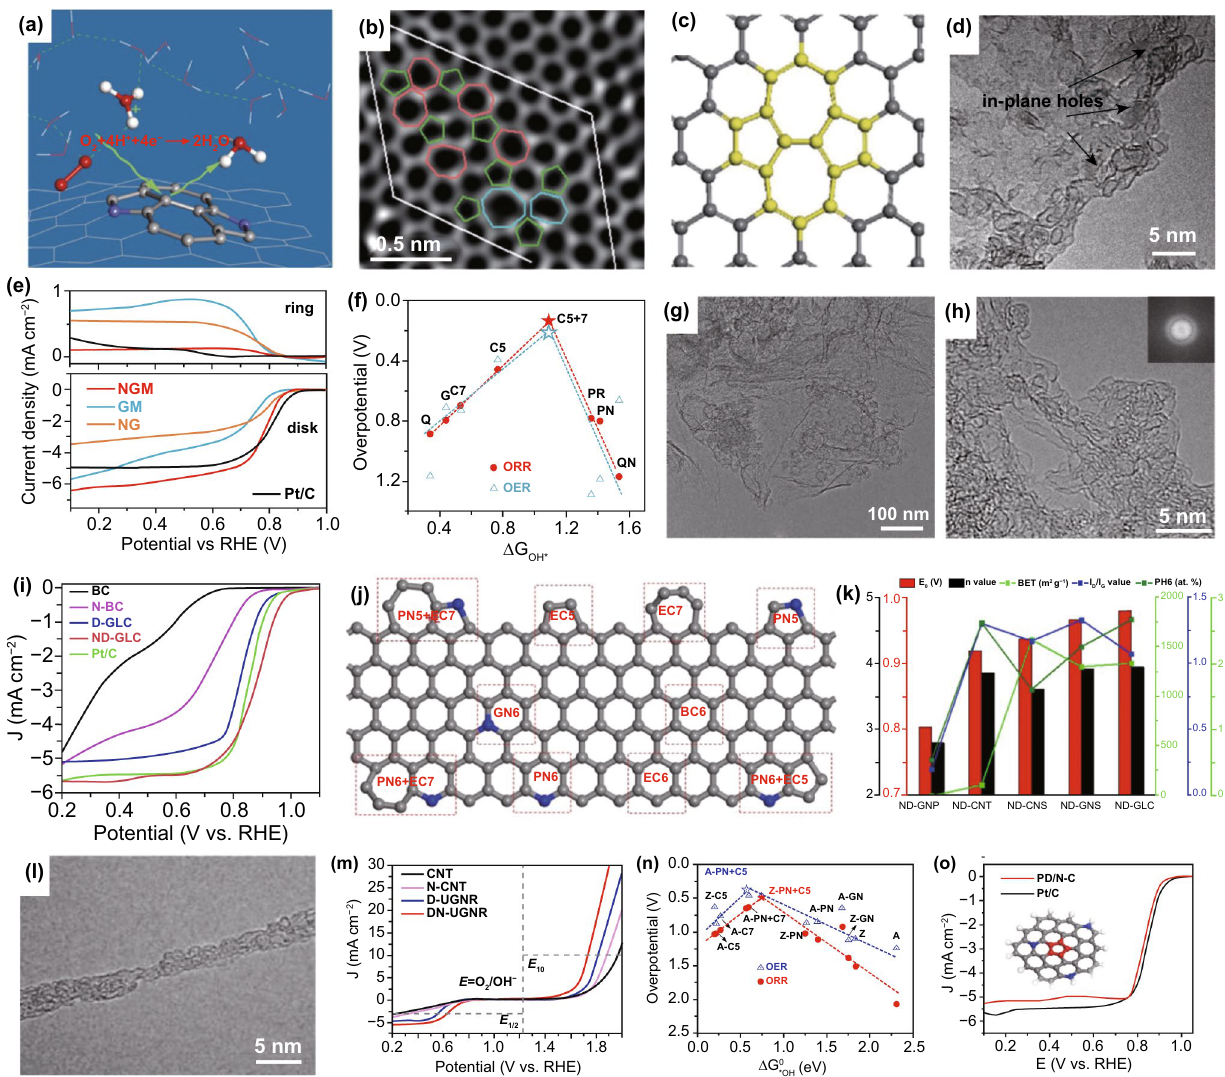
Fig. 7 Topological defects coupled with dopants in nanocarbon for ORR. a Schematic structure of N-pair-doped Stone–Wales defect. Repro- duced with permission from Ref. [118] Copyright 2014, American Chemical Society. b TEM image of single-layer defective graphene; c sche- matic of pyrrolic N-doped graphene with topological defects. Reproduced with permission from Ref. [121]. Copyright 2016, Wiley–VCH. d TEM image of NGM sample; e RRDE measurements of the prepared samples and Pt/C catalyst in O 2 -saturated 0.10 M KOH; f DFT-calculated volcano plots of overpotential versus △ GOH* based on various N dopants and topological defects. Reproduced with permission from Ref. [30]. Copyright 2016, Wiley–VCH. g , h TEM images of ND-GLC; i LSV curves of BC, N-BC, D-GLC, ND-GLC, and Pt/C catalysts; j proposed active sites for ORR based on graphene models; k ORR activities ( E 0 and n value) of the catalysts along with their critical characteristics (BET surface area, I D / I G value, and the content of PN6 dopant). Reproduced with permission from Ref. [77]. Copyright 2018, Elsevier. l TEM image of DN-UGNR; m ORR and OER polarization curves for various samples; n DFT-calculated volcano plots for ORR and OER. o ORR polariza- tion curves for PD/N–C and Pt/C catalysts. Reproduced with permission from Ref. [92]. Copyright 2019,